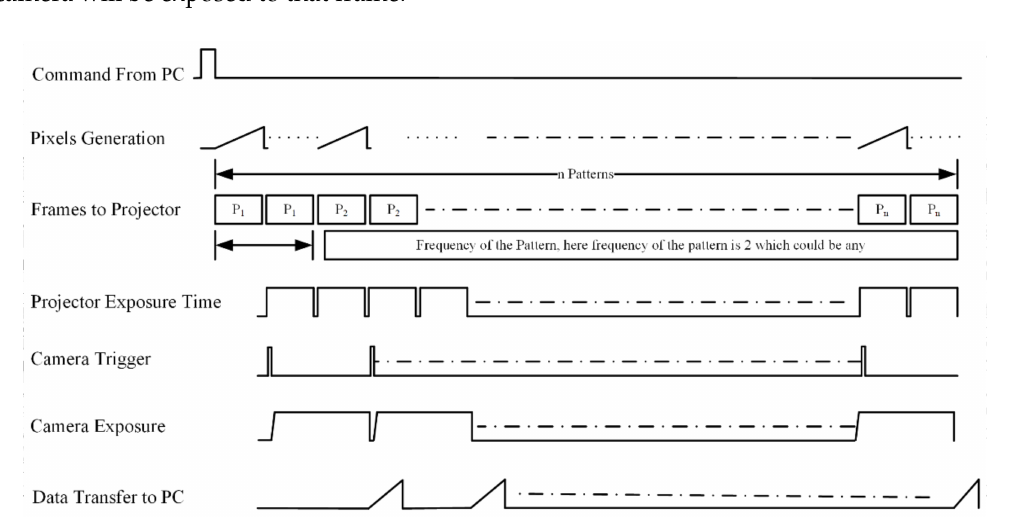
Figure 6. A timing diagram for adaptive frame rate pattern projection for projector camera synchronization when projector screen refresh rate is higher than the camera frame